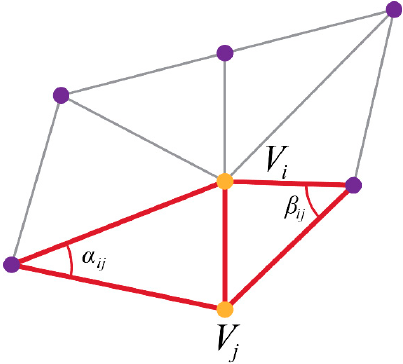
(cid:16) (cid:17) α β are used to i , j , i , j